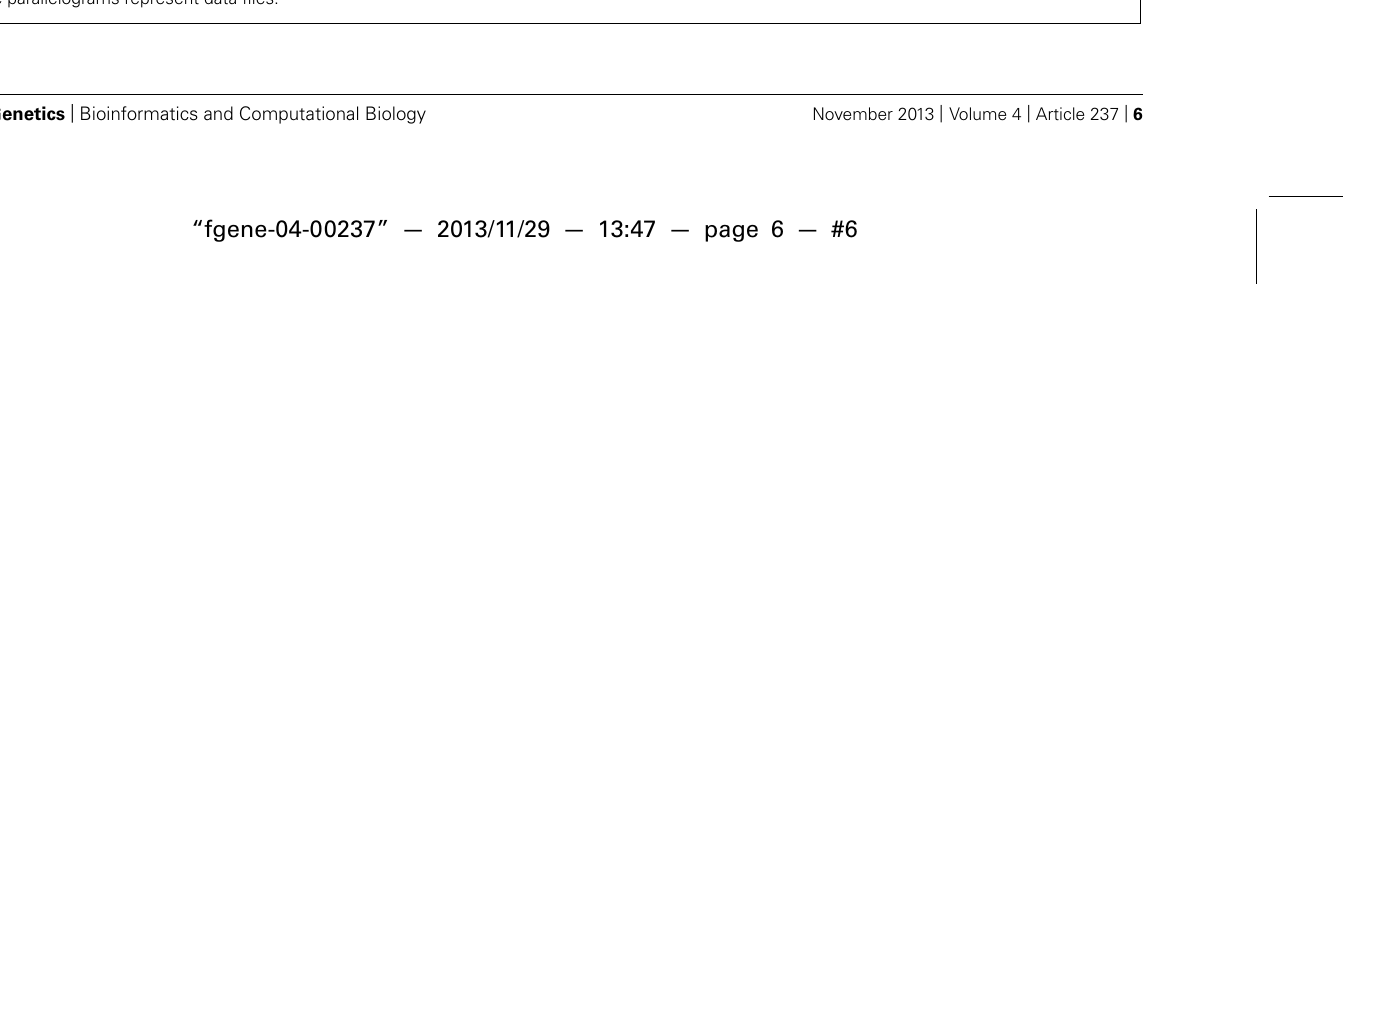
FIGURE 1 |TheTAGC plot workflow. Flowchart showing analysis steps and intermediate data files in theTAGC plot workflow. Rectangles indicate processing stages, while parallelograms represent data